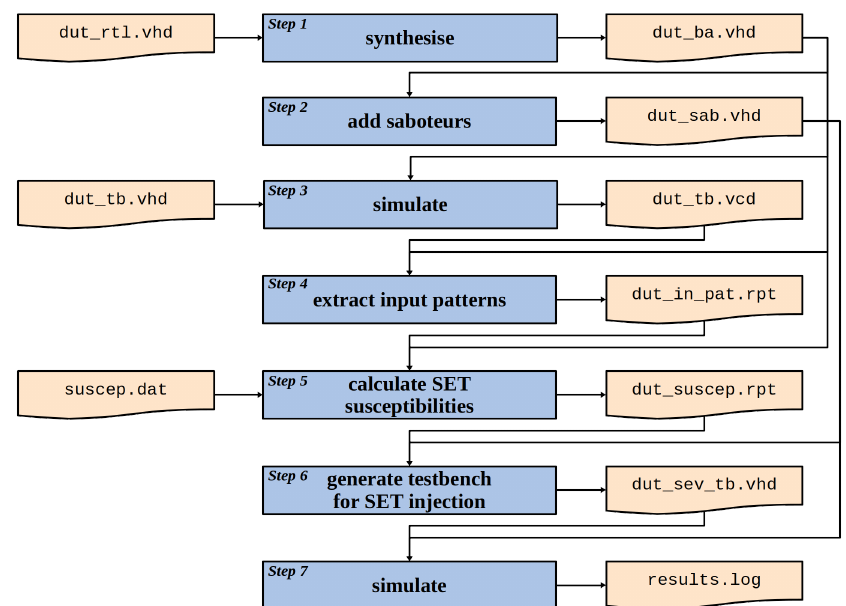
Figure 2. Proposed SEV Estimation Process. The overall process has seven steps that require three inputs to produce the SEV estimation and other six intermediate